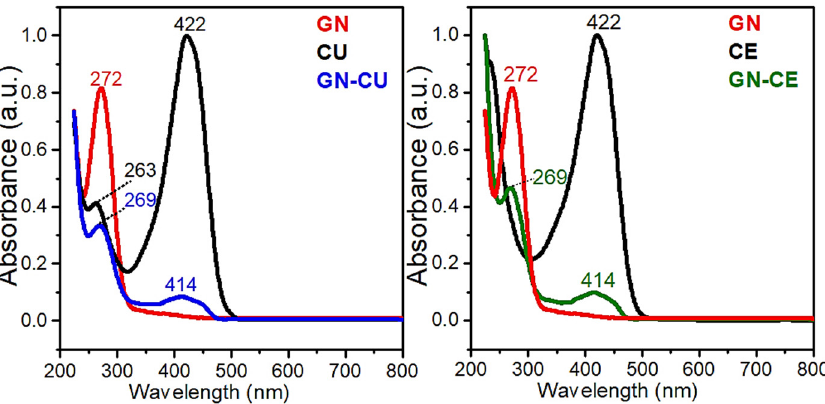
Figure 1. UV–Vis spectra of the GN, CE, CU and GN–CU, GN–CE dispersion in methanol.